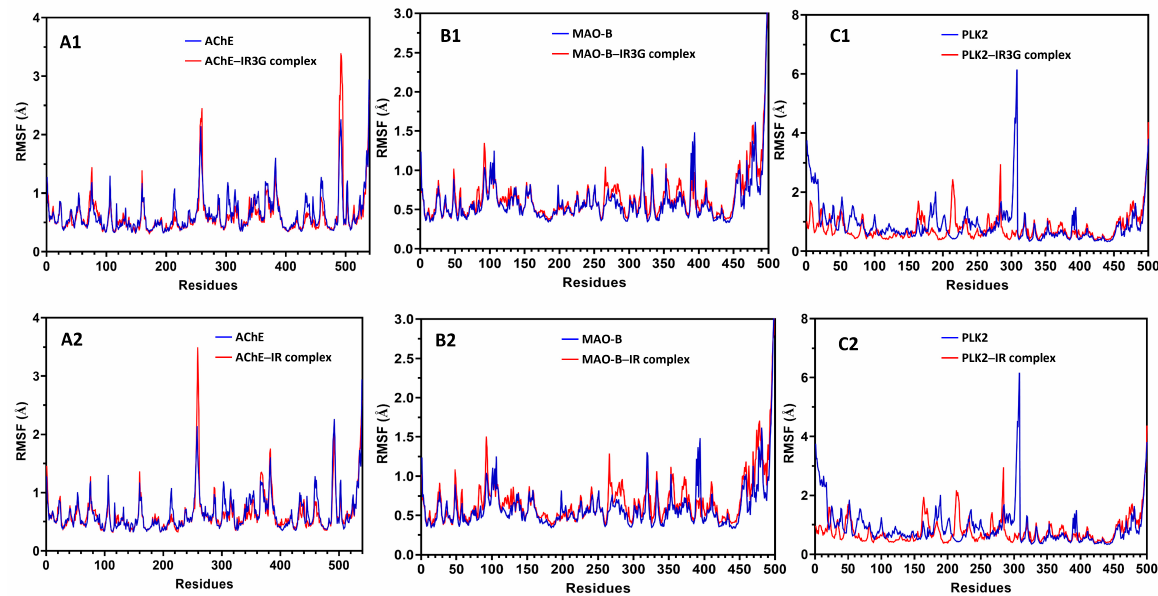
Figure 9. The root mean square fluctuation (RMSF) of the protein backbone during the MD simulation for isorhamnetin-3-O- β -D-glucoside (IR3G) complexes with AChE ( A1 ), MAO-2 ( B1 ), and PLK2 ( C1 ) and RMSF of the protein backbone during the simulation for isorhamnetin (IR) complexes with AChE ( A2 ), MAO-2 ( B2 ), and PLK2 ( C2 ).